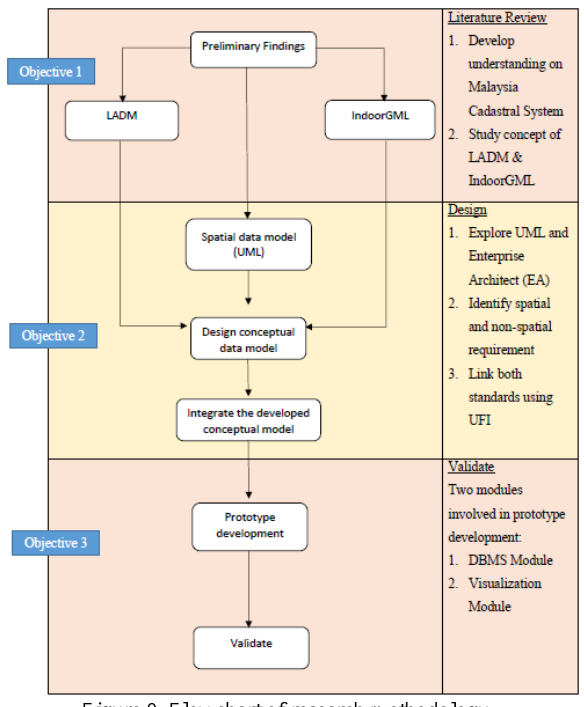
Figure 9. Flowchart of research methodology